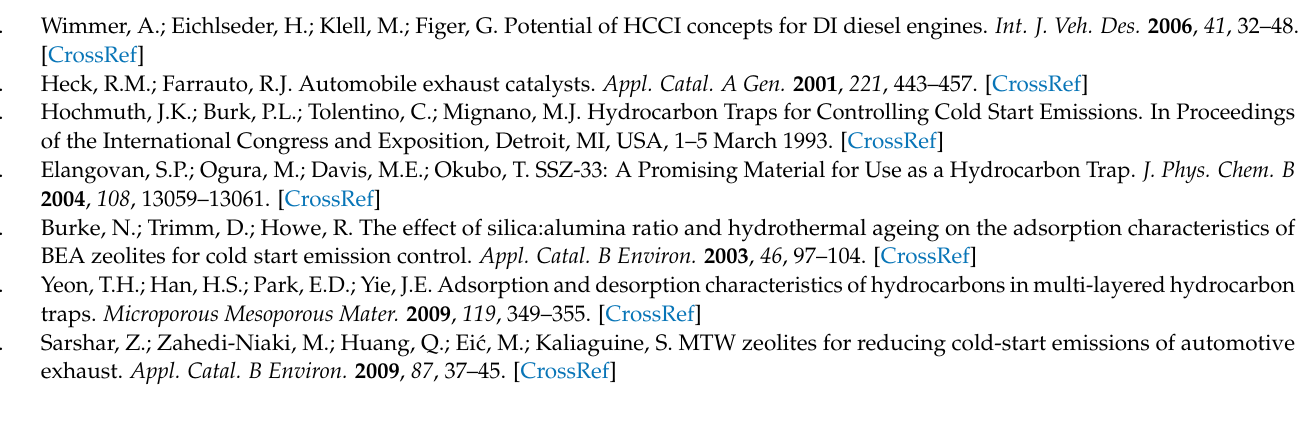
Figure S2: Outlet gas concentrations during TPO for a wet ethylene and CO feed mixture, Figure S3: CO DRIFTS spectra over 1% Pd/BEA of ‘Dry 1 (cid:48) time resolved, Figure S4: CO DRIFTS spectra over 1% Pd/BEA of ‘Wet 2 (cid:48) time resolved, Figure S5: CO DRIFTS spectra over 1% Pd/BEA after 500 ◦ C pretreatment in 2% H 2 , Figure S6: CO TPR under wet conditions, Figure S7: Ethylene TPR under wet conditions, Figure S8: Ethylene co-fed with H 2 under wet